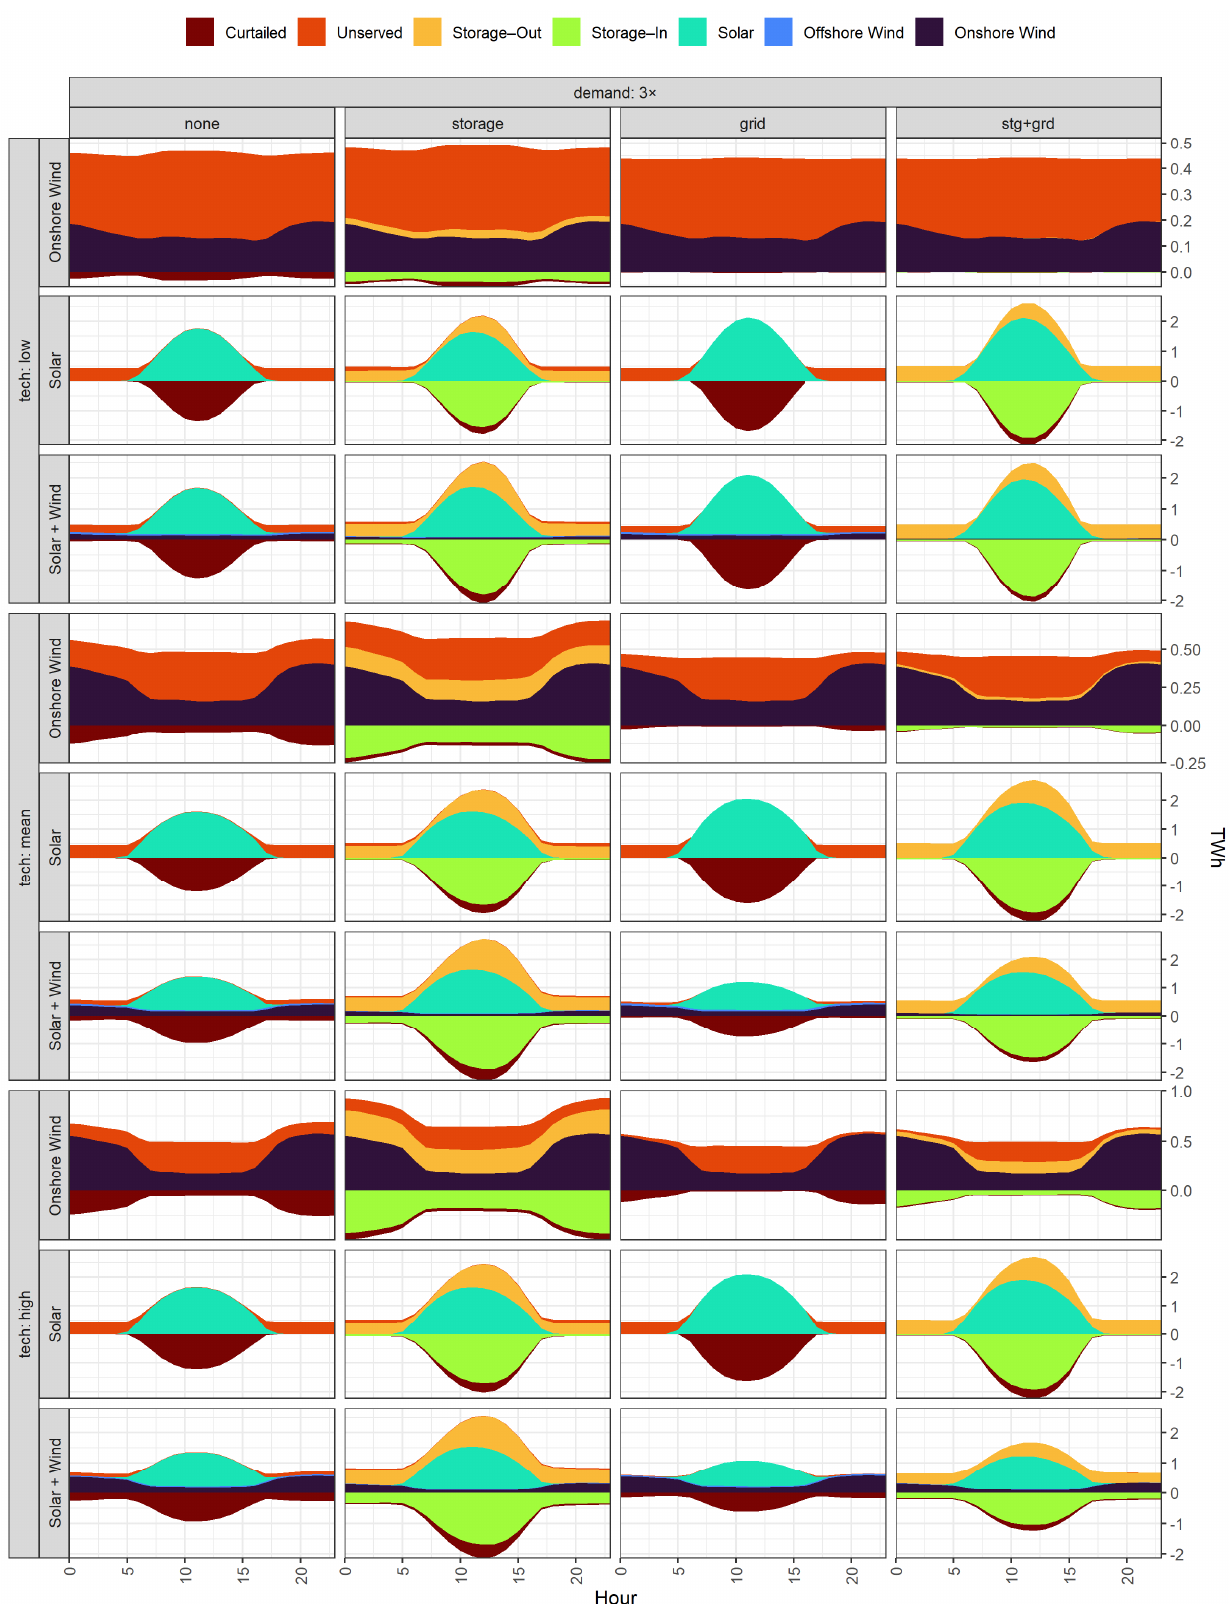
Figure A17. Annual average generation profile by hours and scenario (3× group).